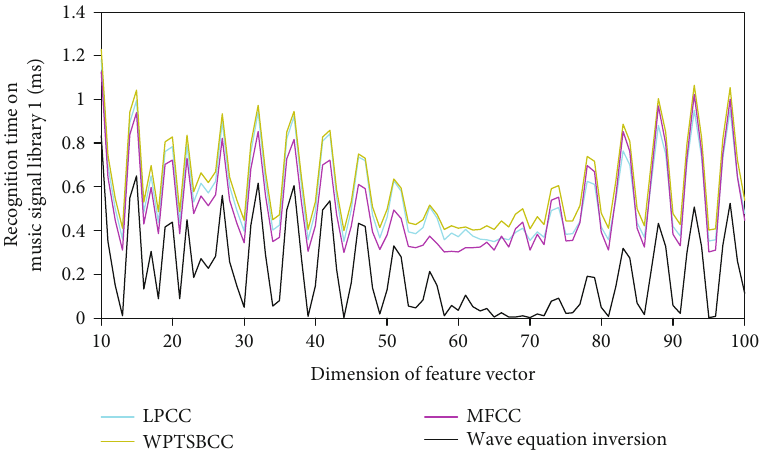
Figure 6: The recognition time of di ff erent feature vector dimensions on the music signal library 1.